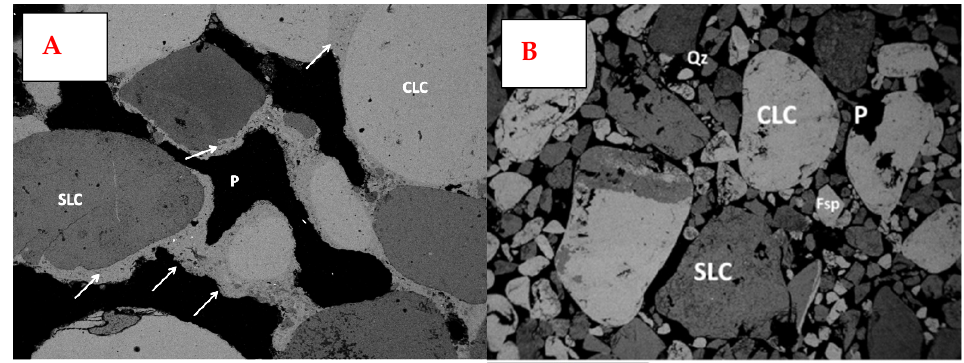
Figure 11. BSE-SEM image of: ( A ): KAN2-1 sample indicating cement to form meniscus bridge and to coat grains (see arrows); ( B ): Texture of L1 beachrock indicating the low degree of cementation and empty pore spaces; CEM: cement; CLC: calcareous lithoclast; Fsp: feldspar; P: pore; Q: quartz; SLC: siceous rich lithoclast.